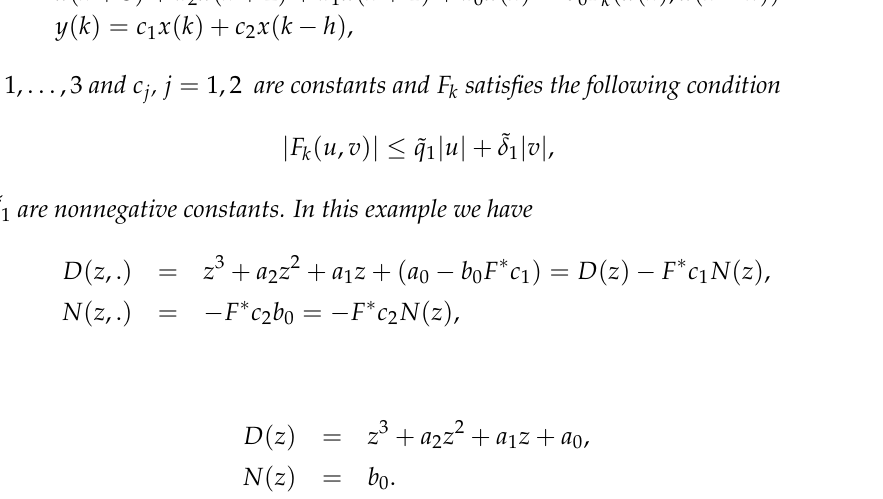
Figure 4. Dynamics evolution of x ( k ) for initial condition x ( k ) = 70, k =